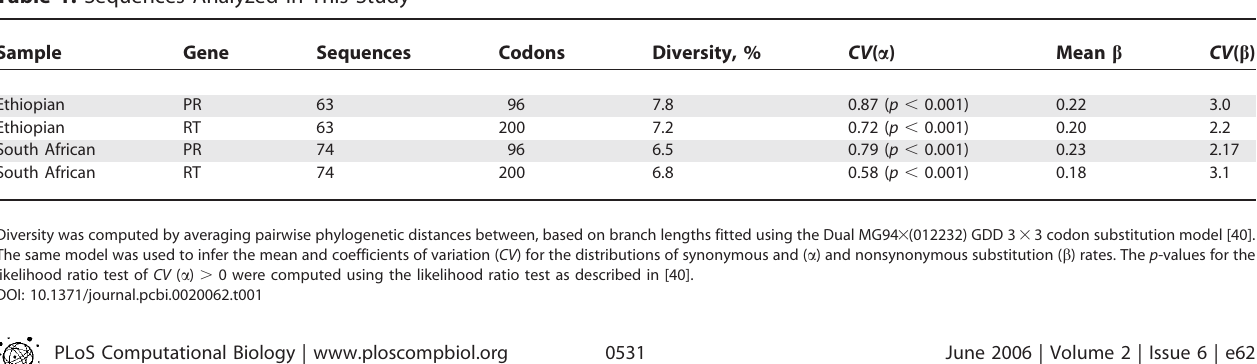
Table 1. Sequences Analyzed in This